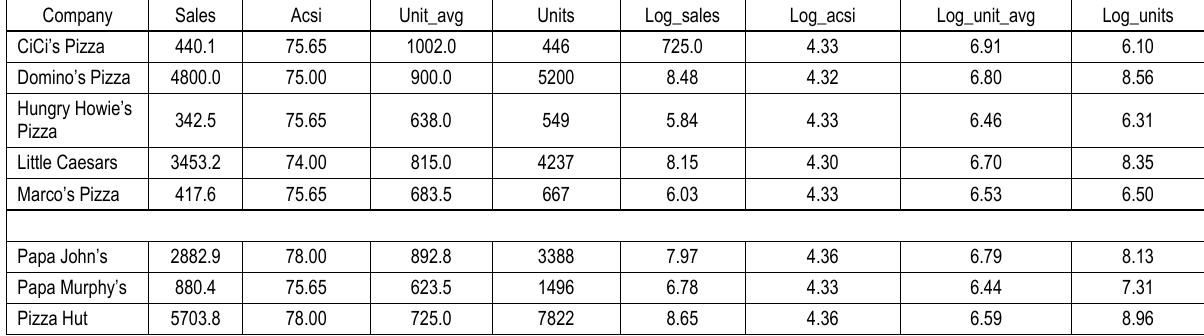
Table 15. Quick service restaurants (segment = pizza)